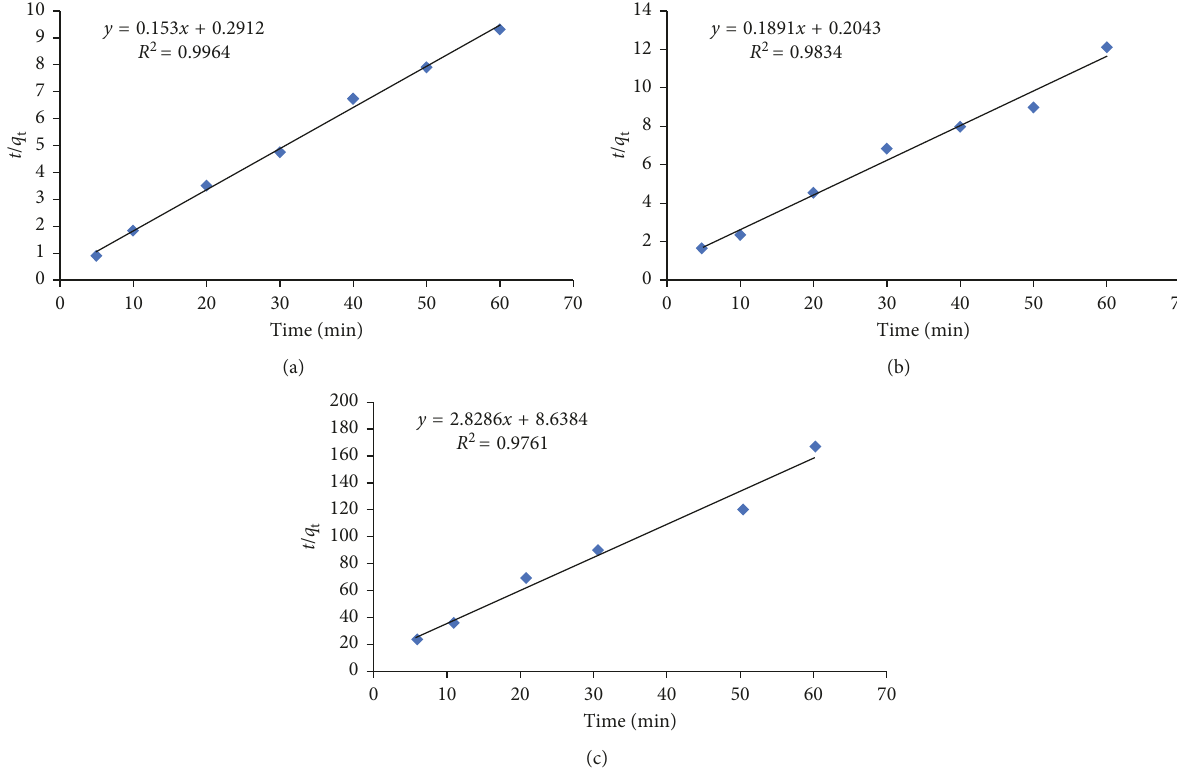
Figure 8: Pseudo-second